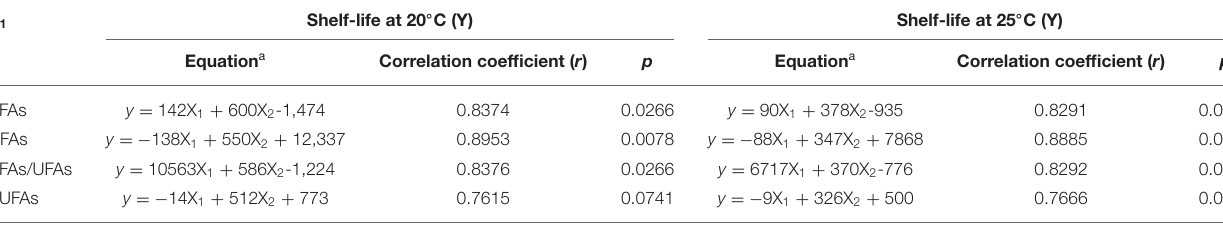
TABLE 6 | Multiple regression analyses between the fatty acid composition and shelf-life of nine expeller-pressed oils. X